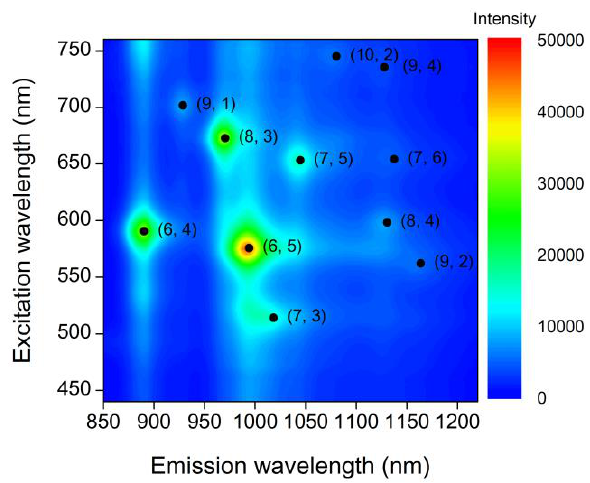
Figure 1. Photoluminescence map of the CNT dispersion used here.